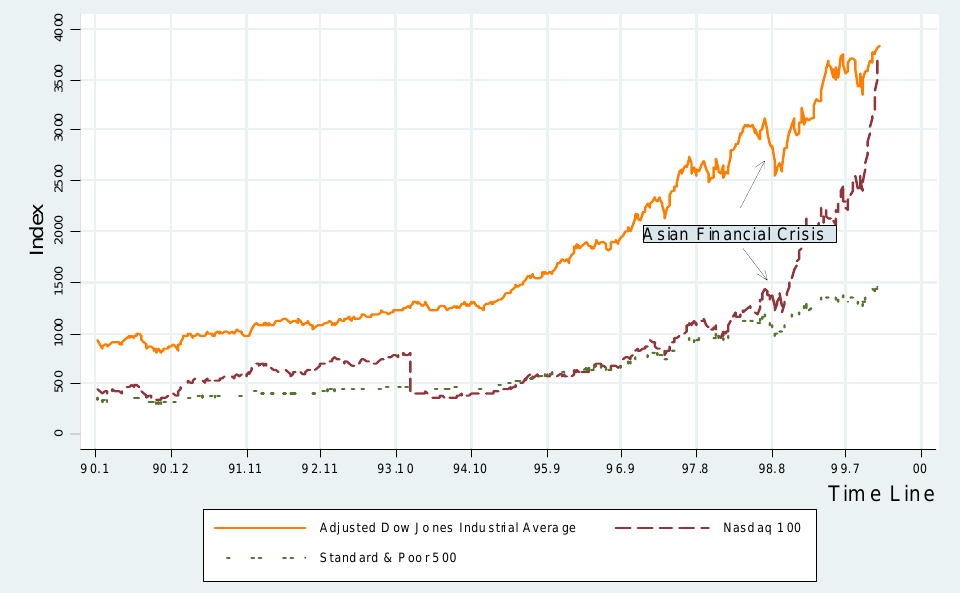
Figure 2: Three Major U.S. Stock Indices (1990 -